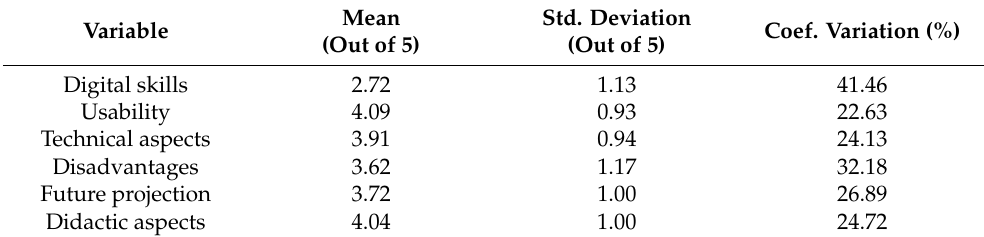
Table 2. Composite reliability (CR) and Cronbach’s alpha parameters.